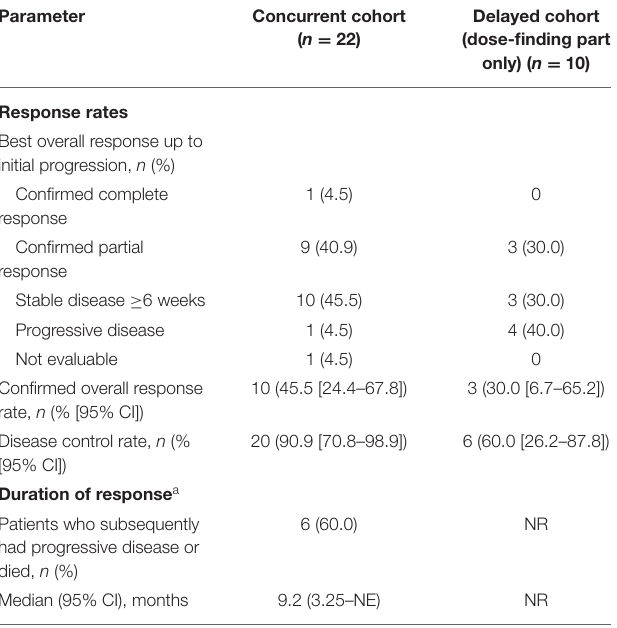
Table 4 | Response rates and duration of response. Parameter